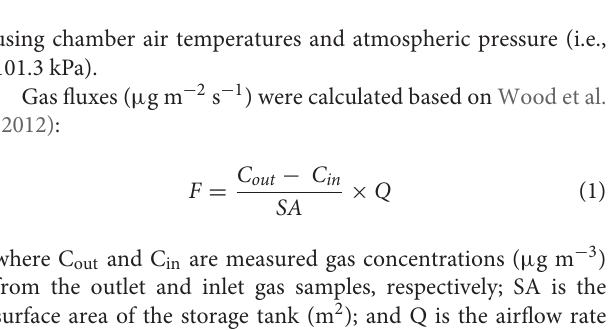
using chamber air temperatures and atmospheric pressure (i.e., 101.3